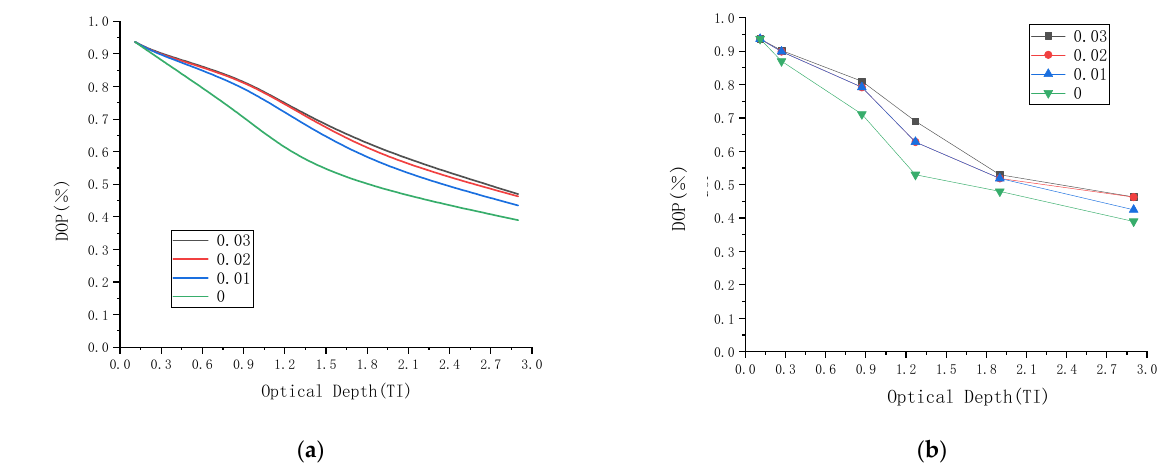
Figure 7. Simulation and experimental comparison of the relationship between salt content at 671 nm and DOP: ( a ) simulation results and ( b ) experimental results.